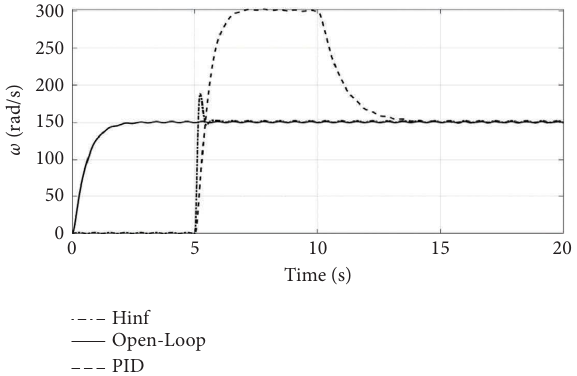
Figure 9: Te angular velocity of the second-order system for τ � 5s and sinusoidal disturbance.